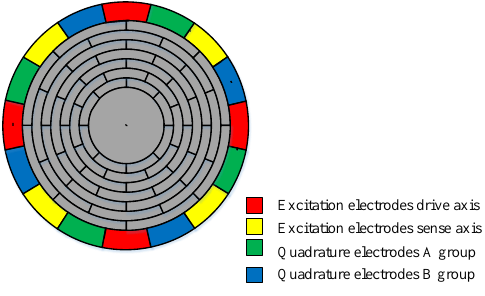
Figure 1. Structure of disk gyroscope.